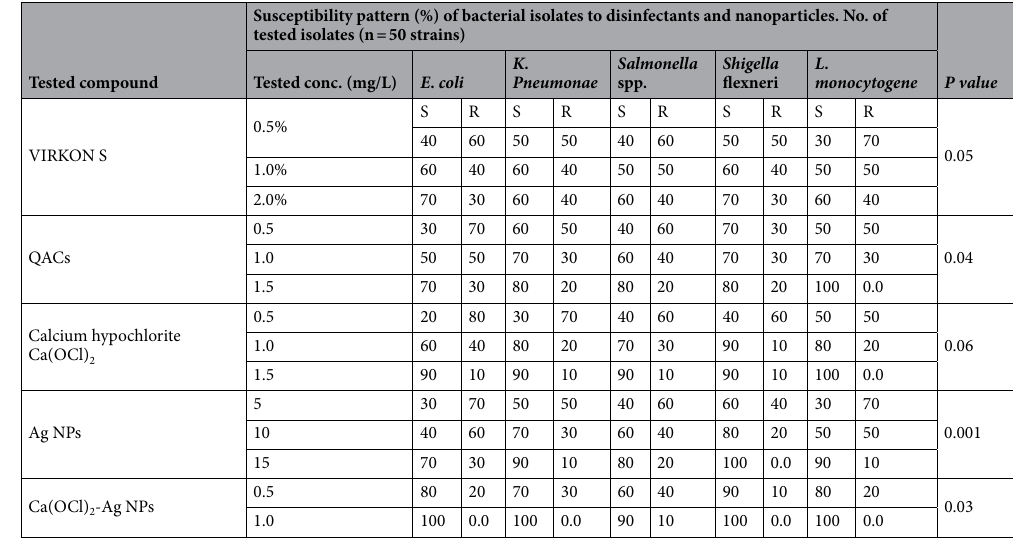
Table 4. Biocidal efficacy of tested disinfectants product and nanocomposite against isolated bacteria from waste types. S Susceptible, R